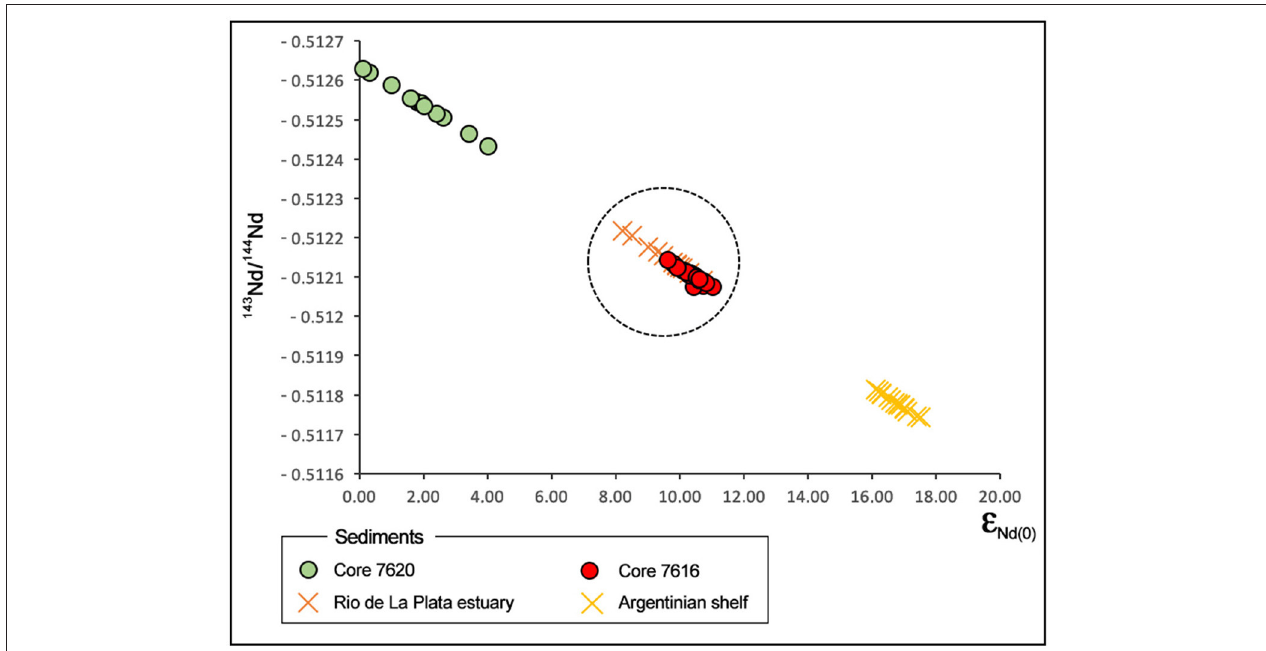
FIGURE 7 | Diagram of ε Nd(0) values vs. 143 Nd/ 144 Nd showing the similarities between the Core 7616 and sediments from the Rio de La Plata